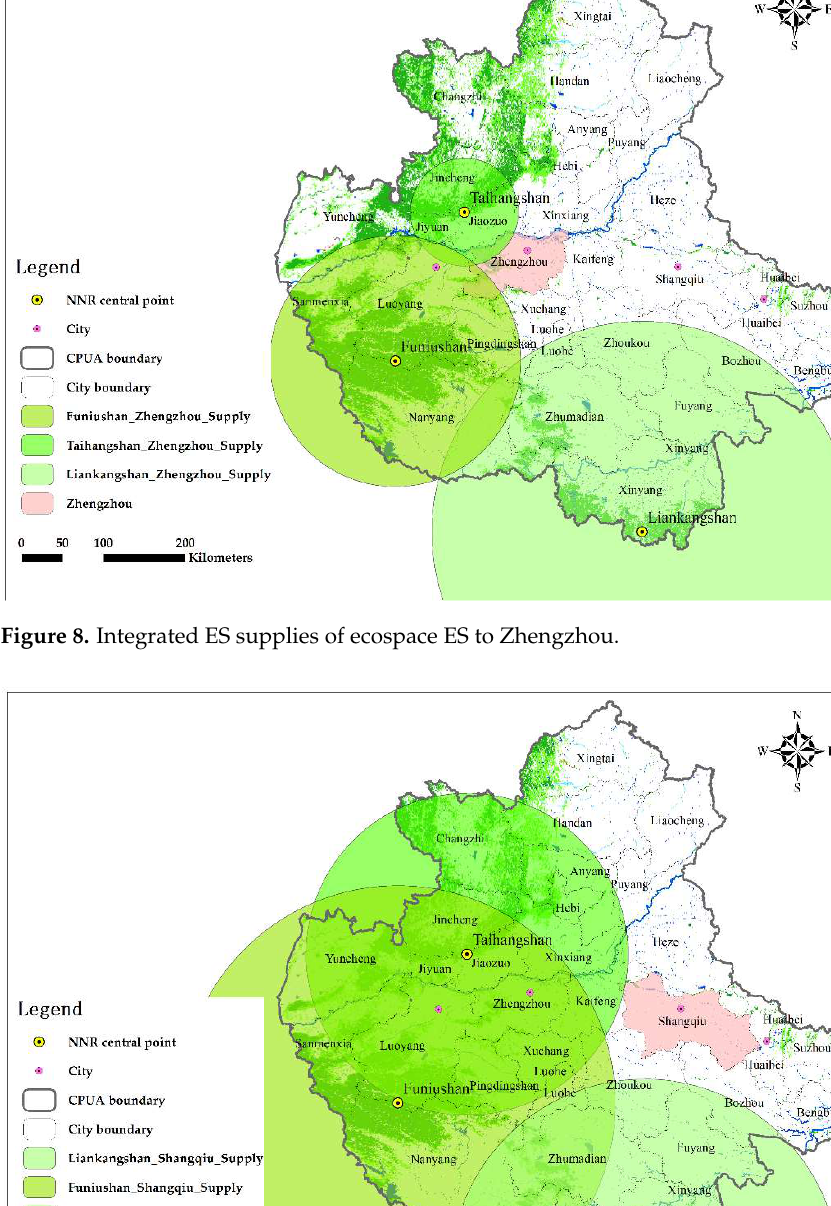
Figure 7. Integrated ES supplies of ecospace ES to Luoyang.